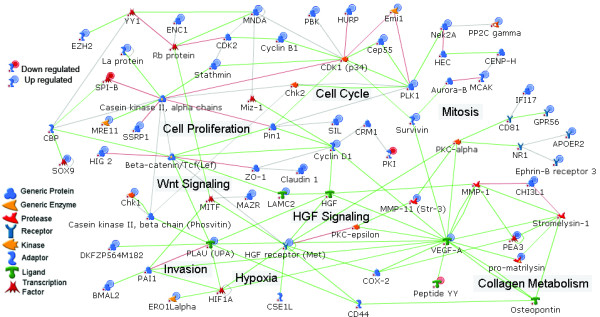
A dense network of molecular interactions containing differentially expressed Core genes in colon cancer. Over- or under-expressed genes, respectively, are indicated by a blue or red disk above-right of the gene-product icon. Green or red lines represent stimulatory or inhibitory interactions, respectively. Many transcription factors (e.g., p53) and signaling kinases (e.g., ERK1) are excluded due to their multiplicity of connections. The general partitioning of the nodes into canonical pathways are shown as bold text.